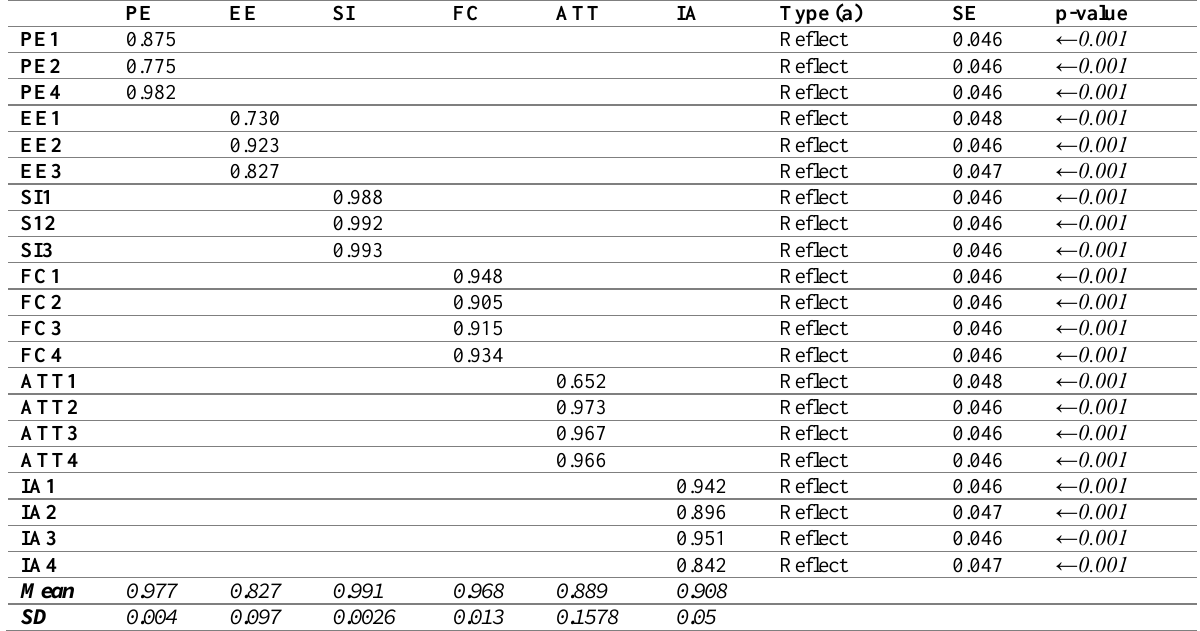
Table 2: Constructs Item Loadings